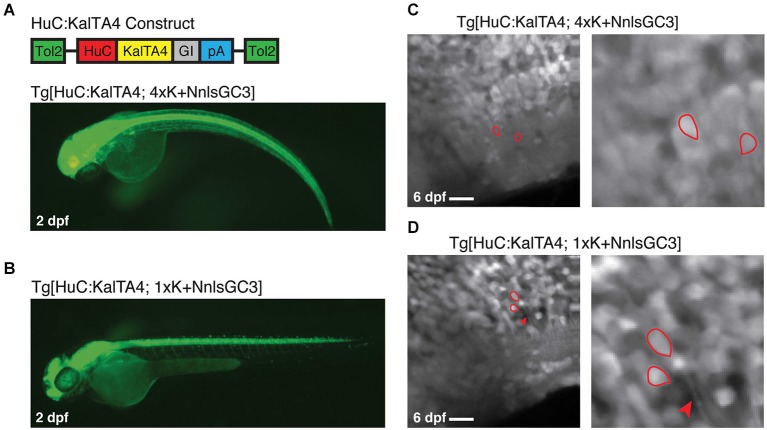
Tg[HuC:KalTA4; 1xK + NnlsGC3] exhibits non-mosaic, dense expression of GCaMP3. (A, B) Epifluorescence images of Tg[HuC:KalTA4; 4xK + NnlsGC3] and Tg[HuC:KalTA4; 1xK + NnlsGC3] at 2 dpf. (C, D) 2PLSM fluorescence images of the caudal hindbrain in Tg[HuC:KalTA4; 4xK + NnlsGC3] and Tg[HuC:KalTA4; 1xK + NnlsGC3] at 6 dpf. Example cells with both nuclear and cytoplasmic expression of GCaMP3 are outlined in red, and the red arrowhead in (D) points to a fluorescent neuronal process. Scale bars represent 18 μm.